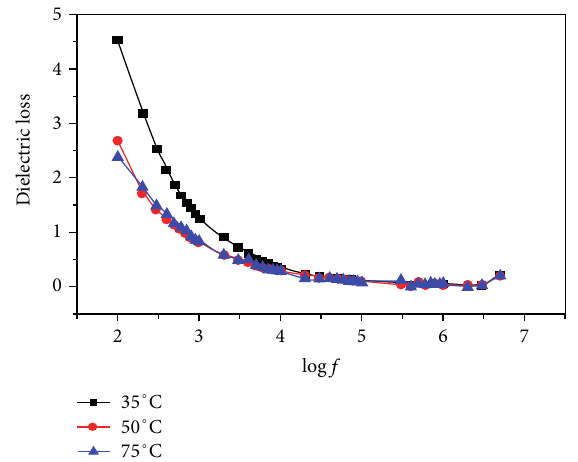
F 4: Variation of dielectric loss with frequency.